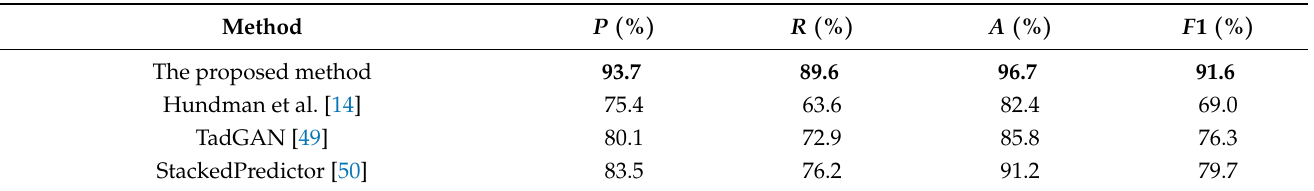
Table 3. Comparison with advanced